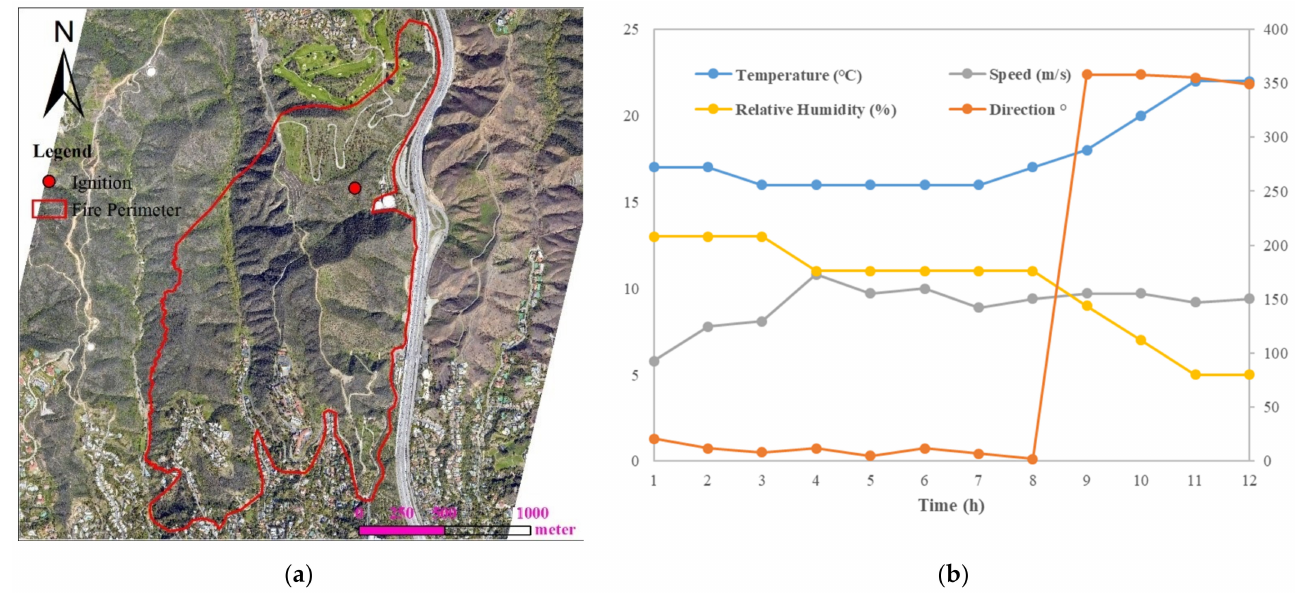
Figure 1. Study case in Getty Fire. ( a ) Wildfire region; ( b ) historical weather data. All models were executed on the same hardware equipment, a 4-core (2.30 GHz) Inter(R) Core (TM) i7-10510U laptop with 16 GB of RAM. The final perimeter of Getty